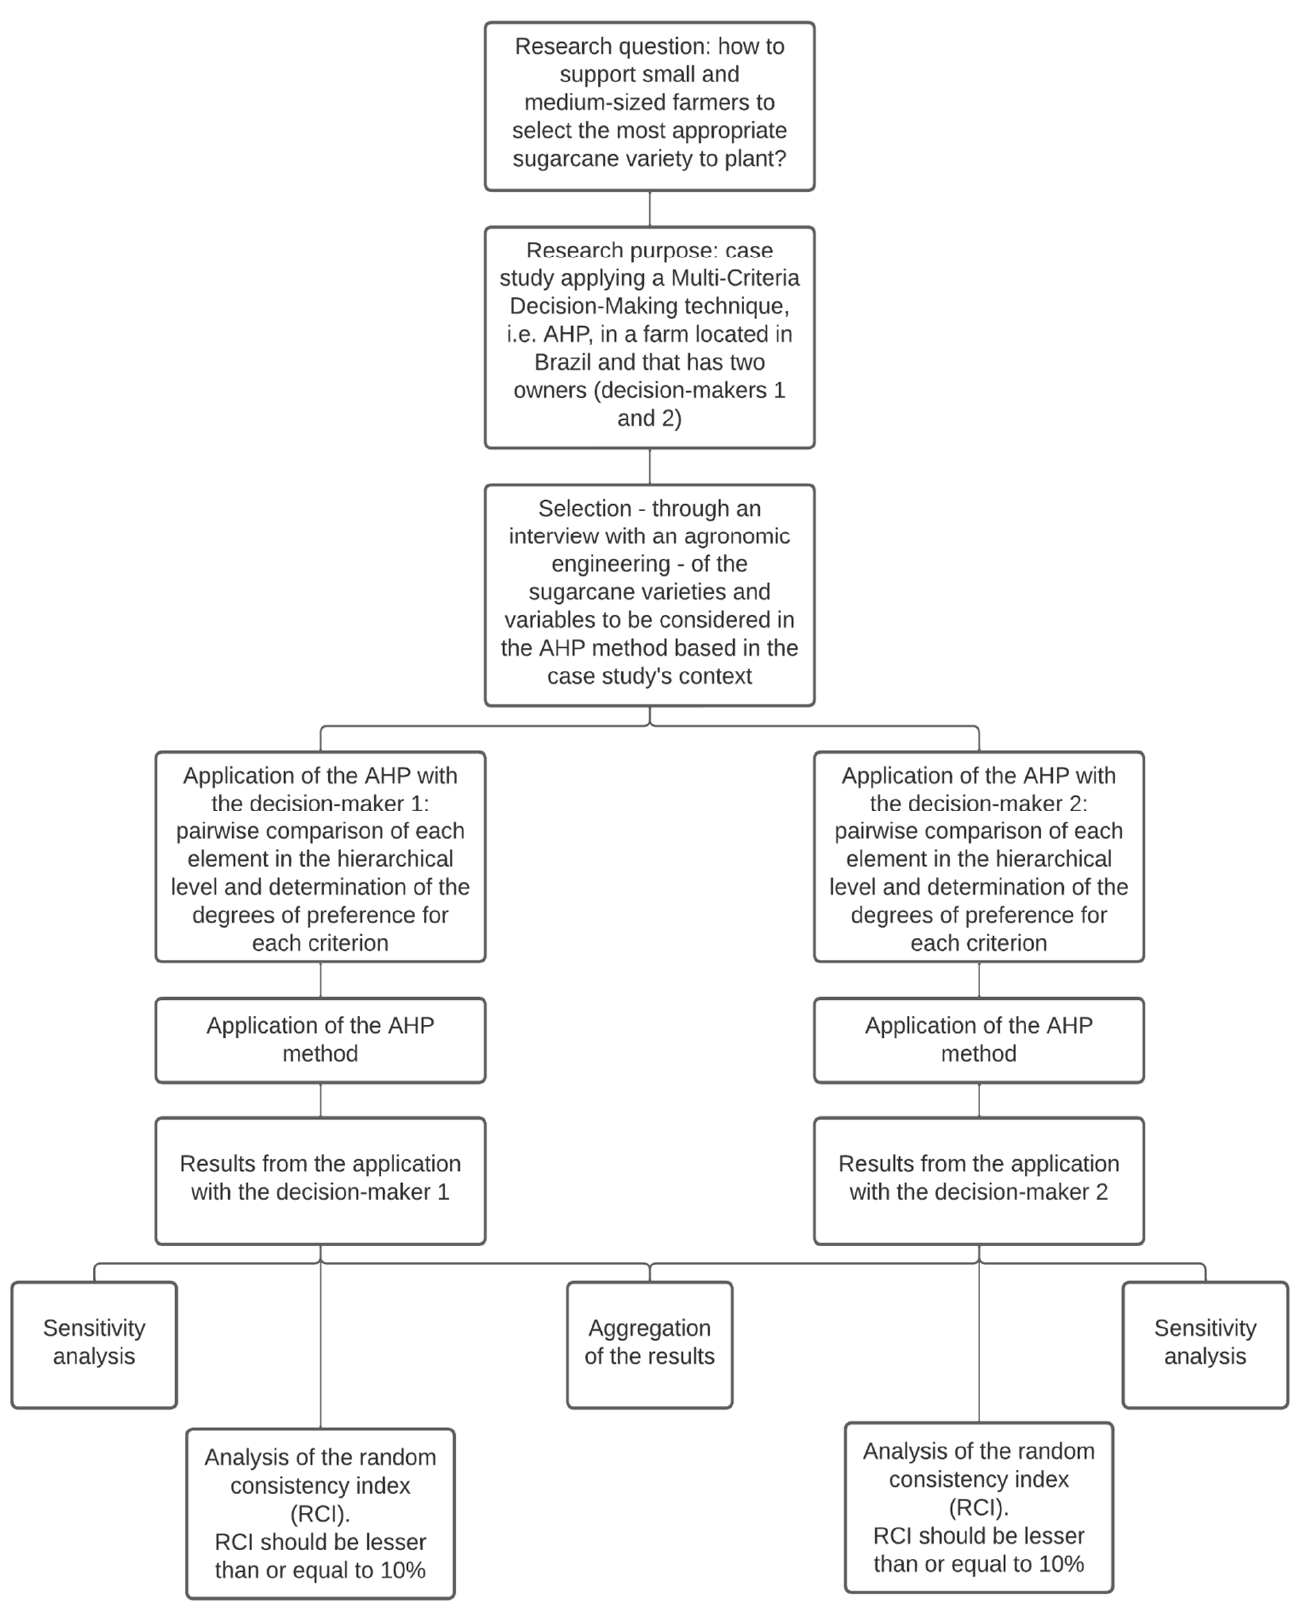
Figure 4. Flowchart describing all of the steps of the AHP method applied in this research.